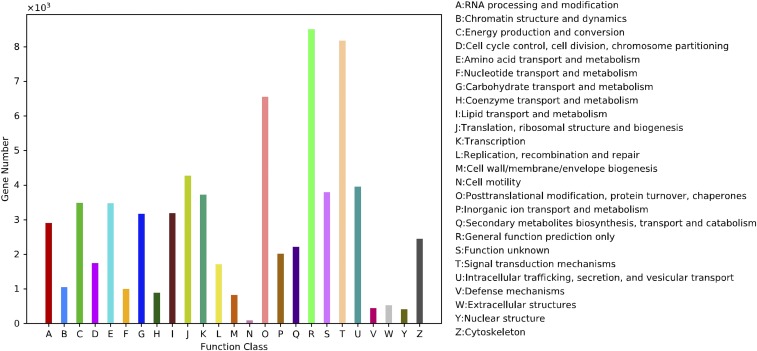
Eukaryotic orthologous group (KOG) categories A total of 62,877 unigenes were annotated into 25 categories. The y-axis represented number of unigenes.